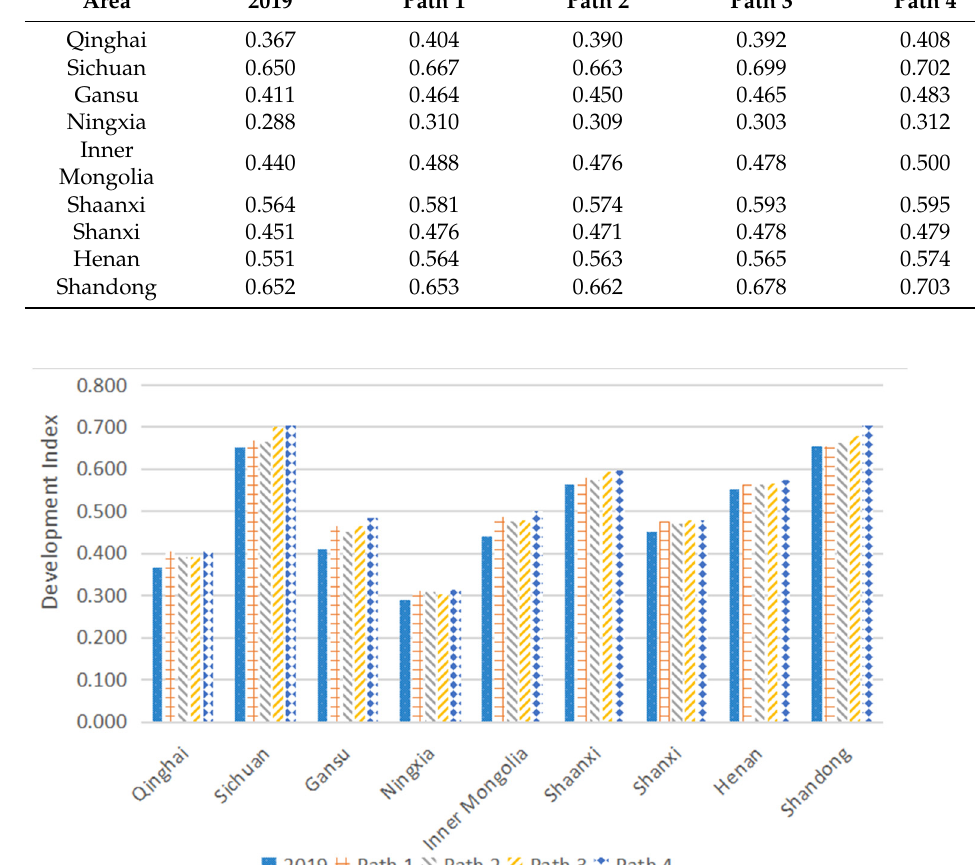
Figure 6. Dynamic changes in the development index of each province.